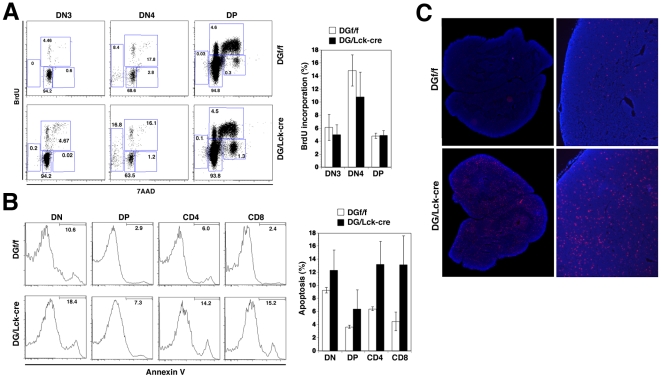
Unaffected Cell Cycle Progression but Increased Cell Death in DG/Lck-cre Mice.(A) Normal cell cycle profile in DN3, DN4, and DP thymocytes from adult thymi. Mice were inoculated with 1 mg/ml BrdU intraperitoneally 2 h before the thymus was harvested. Thymocytes were stained with the antibodies described in Materials and Methods to define thymocyte subsets. Cell cycle was analyzed by the staining with anti-BrdU antibody and 7AAD. Representative plots of BrdU vs 7AAD on gated DN3, DN4, and DP thymocytes are shown (left). Percentage of BrdU+ cells among DN3, DN4, and DP thymocytes are graphed (right). Data were derived from 4 mice of each genotype. (B) Apoptosis of thymocytes was analyzed by the staining with annexin V and 7AAD. Representative histograms of annexin V in various thymocyte subsets are shown (left). The percentages of annexin V+ cells in each subset are displayed. Representative data from one of at least four independent experiments are shown. Mean ± SD from 6 mice of each genotype. (C) In situ staining of apoptotic cells by TUNEL assay on the frozen thymus section. Images were taken at 5× magnification (C) and reconstructed (D) using MosaiX software.